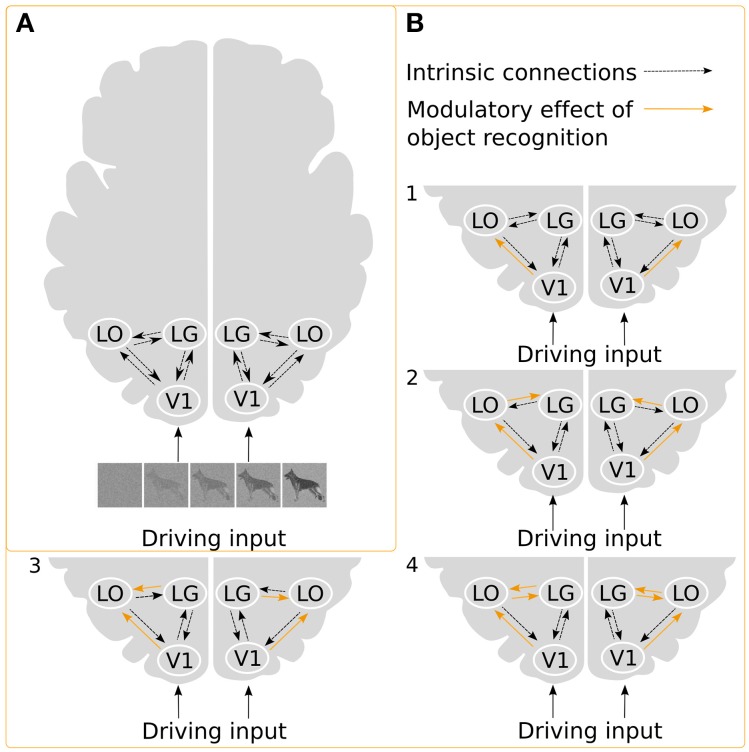
Illustration of the DCMs. (A) Intrinsic connections and the driving input of the stimuli. (B) Examples of possible ways in which object recognition could modulate effective connectivity. In model 1, object recognition alters the connectivity from V1 to LO, and modulation of the intrinsic connection changes between LG and LO, in model 2, object recognition modulates connectivity from V1 to LO as well as from LO to LG, while in model 3, the connectivity from LG to LO is modulated. Finally, in model 4, modulations affect both directions between LG and LO.